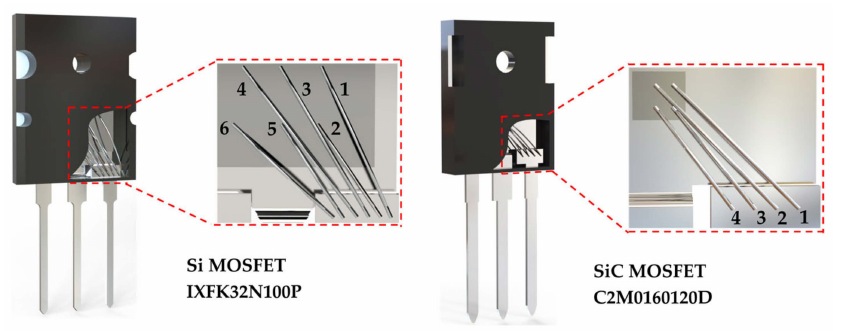
Figure 4. Internal structure of IXFK32N100P and C2M0160120D in TO − 247, and the serial number marked on each bond